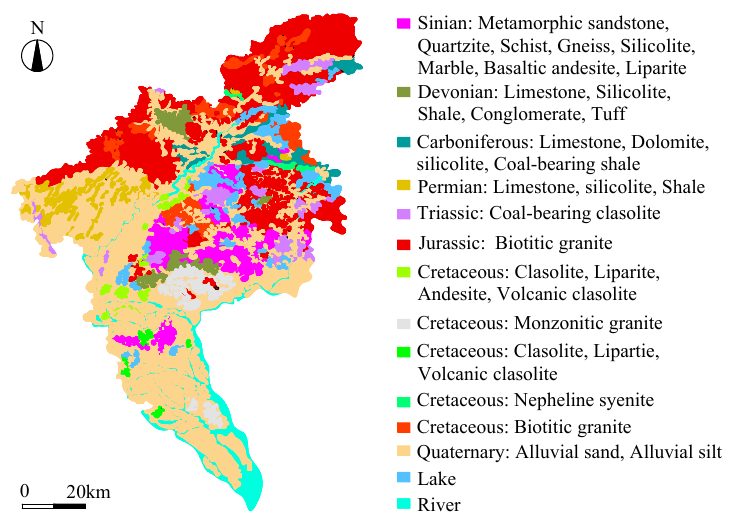
Figure 4. Geological map of Guangzhou (data from Ren et al., 2016 [67]).